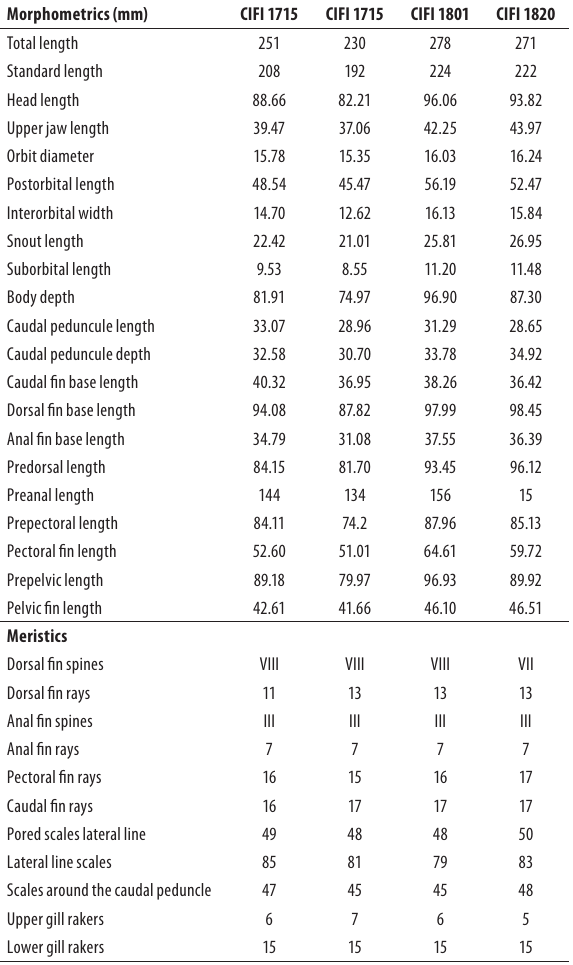
Figure 2. Gonioplectrus hispanus (CIFI-1715, 208 mm SL) collected in the south-western Gulf of Mexico, showing typical coloration for the species. The species was determined prior to the preservation of the specimen. Scale bar = 25 mm. Table 1. Morphometric and meristic data of specimens of Gonio- plectrus hispanus from the south-western Gulf of